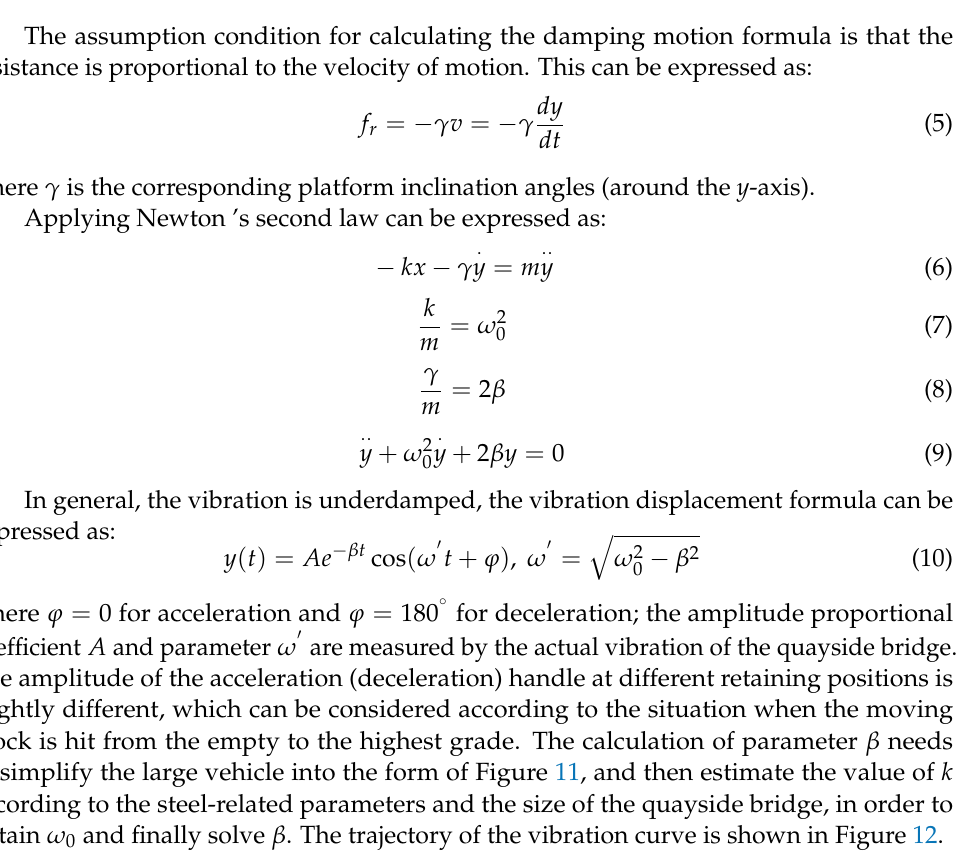
Figure 11. Simplified mechanical model of quayside bridge crane.